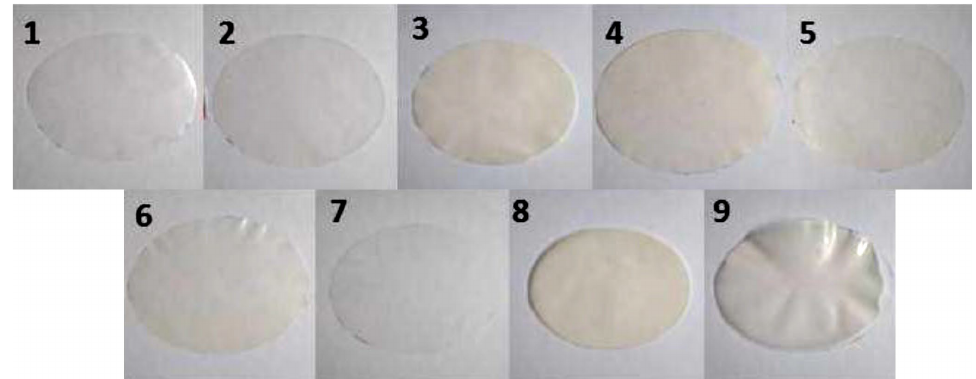
Figure 1. Photographs of the methyl cellulose and poly(vinyl alcohol) films elaborated with nanocrystalline cellulose (CNC) and natamycin: 0.7% of CNC and 0.7% of natamycin (1), 4.3% of CNC and 0.7% of natamycin (2), 0.7% of CNC and 4.3% of natamycin (3), 4.3% of CNC and 4.3% of natamycin (4), 0% of CNC and 2.5% of natamycin (5), 5% of CNC and 2.5% of natamycin (6), 2.5% of CNC and 0% of natamycin (7), 2.5% of CNC and 5% of natamycin (8), and 2.5% of CNC and 2.5% of natamycin (9). Table 2. Results obtained for optical parameters (tendency to yellow, b*, opacity, OP, and yellow index, YI), thickness, mechanical properties (ultimate tensile strength, UTS, elongation at break, EB, Young’s modulus, YM), water vapor permeability (WVP), and oxygen permeability (O 2 P) of films elaborated with methyl cellulose, poly(vinyl alcohol), cellulose nanocrystals, and natamycin.